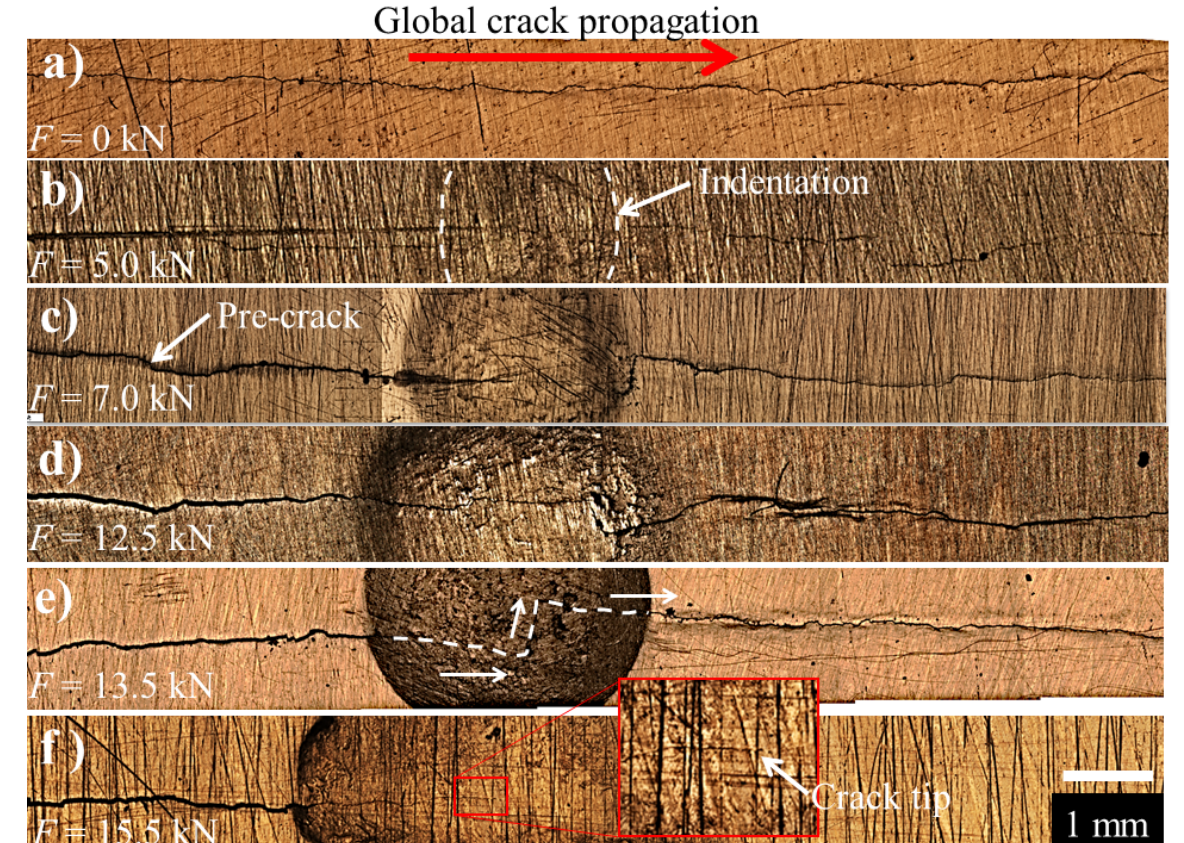
Figure 11. General view of the fatigue crack for the 7075-T651 aluminum alloy, ( a ) base material (non-LCD), ( b – f ) different LCD conditions (compressive force from 5.0 to 15.5 kN).